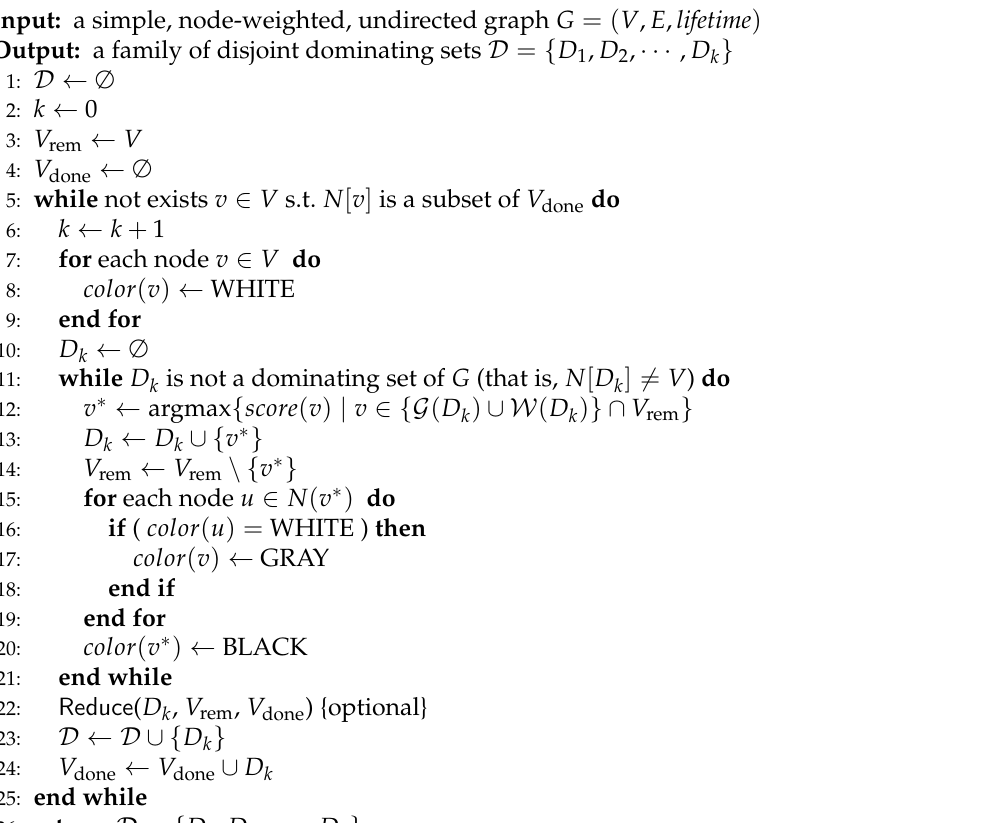
Algorithm 1 GH-MWDDS: A Greedy heuristic for the MWDDS